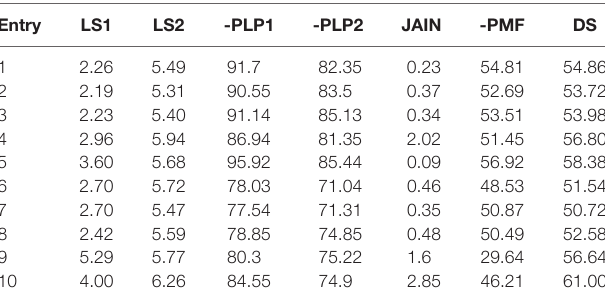
TaBle 2 | Molecular docking results of p65 with oxadiazoles.